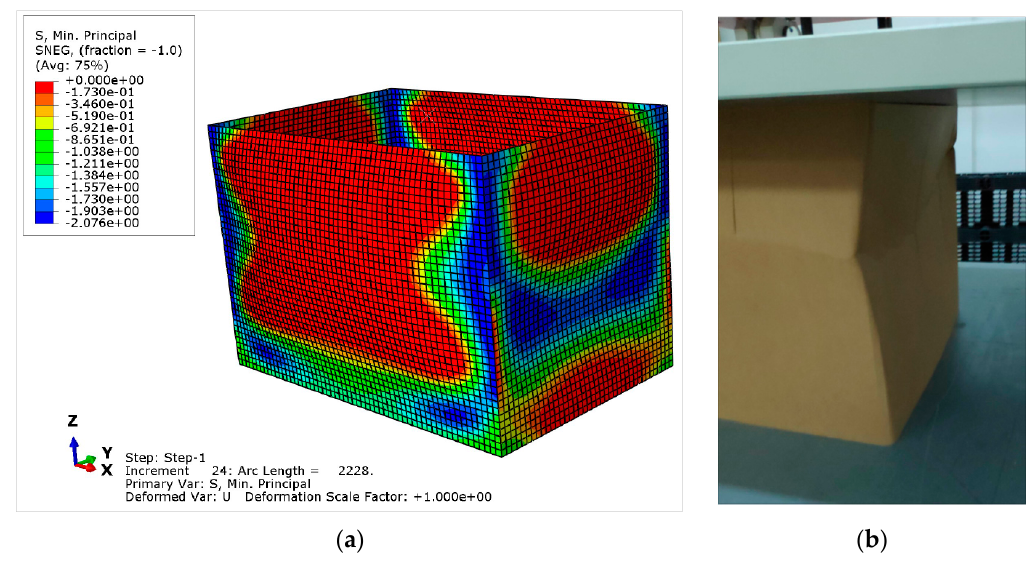
Figure 13. Qualitative comparison between CAE and experimentation for R-04 item: ( a ) CAE deformed model and stress field (stress legend in MPa); ( b ) Deformed sample in the BCT test.